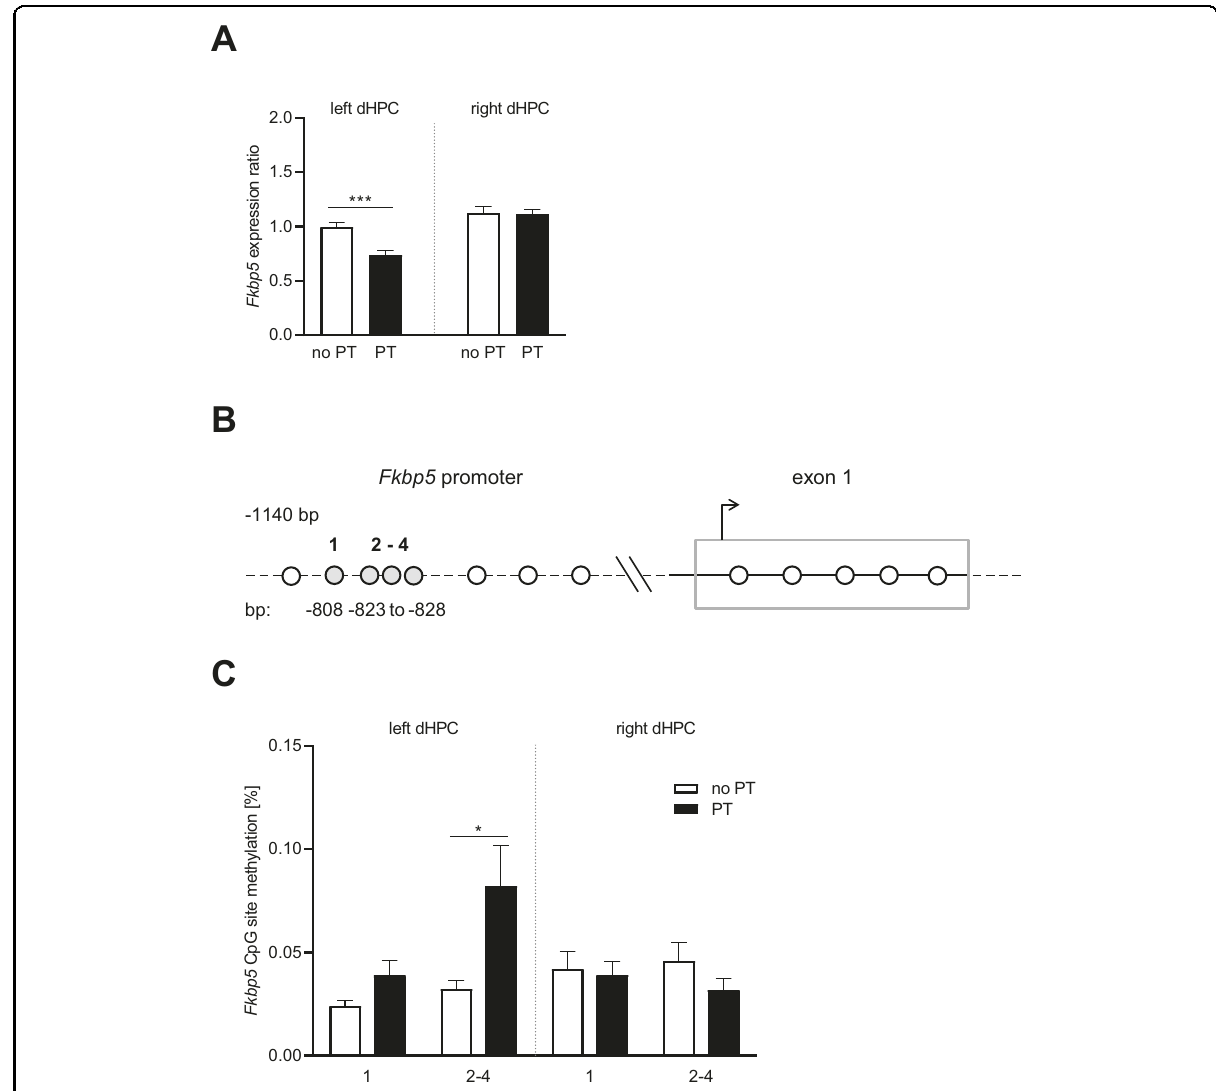
Fig. 4 Expression and methylation analysis of Fkbp5 in in the dHPC of PT adult male mice compared to a no PT control group. A Expression analysis of Fkbp5 in the left and right dHPC (the dotted gray line separates the results from left and right dHPC). Fkbp5 expression was signi fi cantly decreased in the left dHPC of PT offspring (*** p < 0.001, post hoc Fisher ’ s LSD test), but not changed in the right dHPC as compared to no PT mice. B The promoter and the fi rst exon of Fkbp5 were analyzed for methylation changes. The gray circles indicate the differentially methylated CpG sites. The positions of the respective CpG sites are based on NC_000083.6 ( Mus musculus strain C57BL/6J chromosome 17, GRCm38.p4). C Differentially methylated Fkbp5 CpG sites in the left and right dHPC of PT and no PT mice. The dotted gray line separates the results from left and right dHPC. CpG sites 2 – 4 are in juxtaposition to each other and thus have been analyzed together due to technical limitations. * p < 0.05, independent samples t / u - test. See “ Results ” for detailed statistical vs. PT: p < 0.001; PT, left vs. right dHPC: p < 0.0001, PT and/or being raised by a traumatized mother is Fisher ’ s LSD test) (Fig. 4A). Comparing the right dHPC of associated with long-term changes in hippocampal gene PT and no PT mice, as well as both hemispheres of the methylation latter, Fkbp5 expression was not signi fi cantly altered Methylation analysis of the promoter region of Crhr1 (right dHPC, no PT vs. PT: p = 0.817 [n.s.]; no PT, left vs. (Fig. 3C) in the left dHPC revealed a signi fi cant hypo- right dHPC: p = 0.061 [n.s.], Fisher ’ s LSD test) (Fig. 4A). methylation in CpG site #1 at − 1520 bp ( t = 2.628, df = Regarding the expression of Nr3c1 and Nr3c2 , no dif- 18, p = 0.02) and in two CpG sites with a trend toward ferences were detected in the right and left dHPC (data signi fi cance ( t = 2.73, df = 16, p = 0.06; t = 2.09, df = 13, p = 0.06) in PT mice (Fig. 3D). Moreover, we identi fi ed not shown).